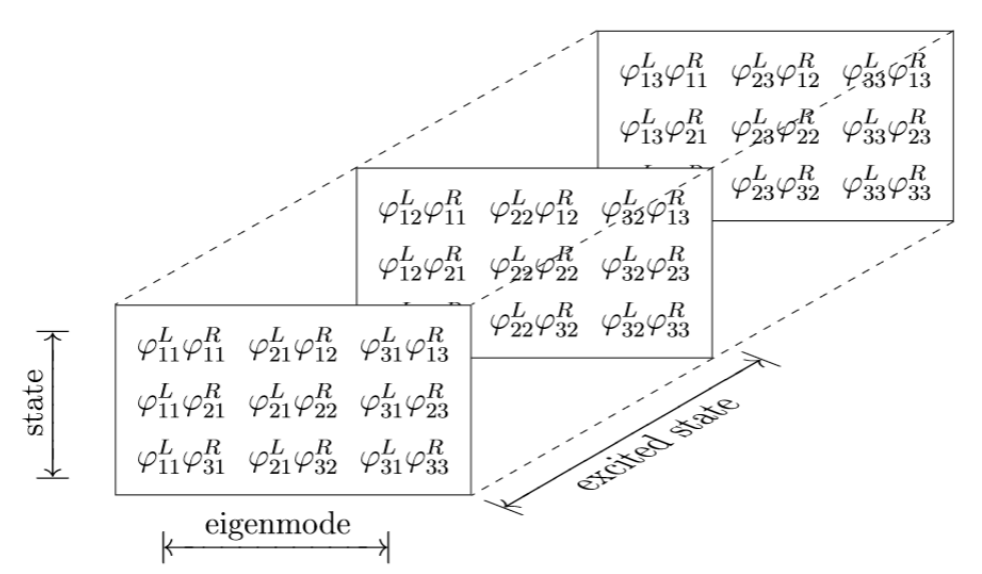
Figure 2. Three-dimensional representation of new modal quantities matrix γ in the case of a 3-degrees-of-freedom system